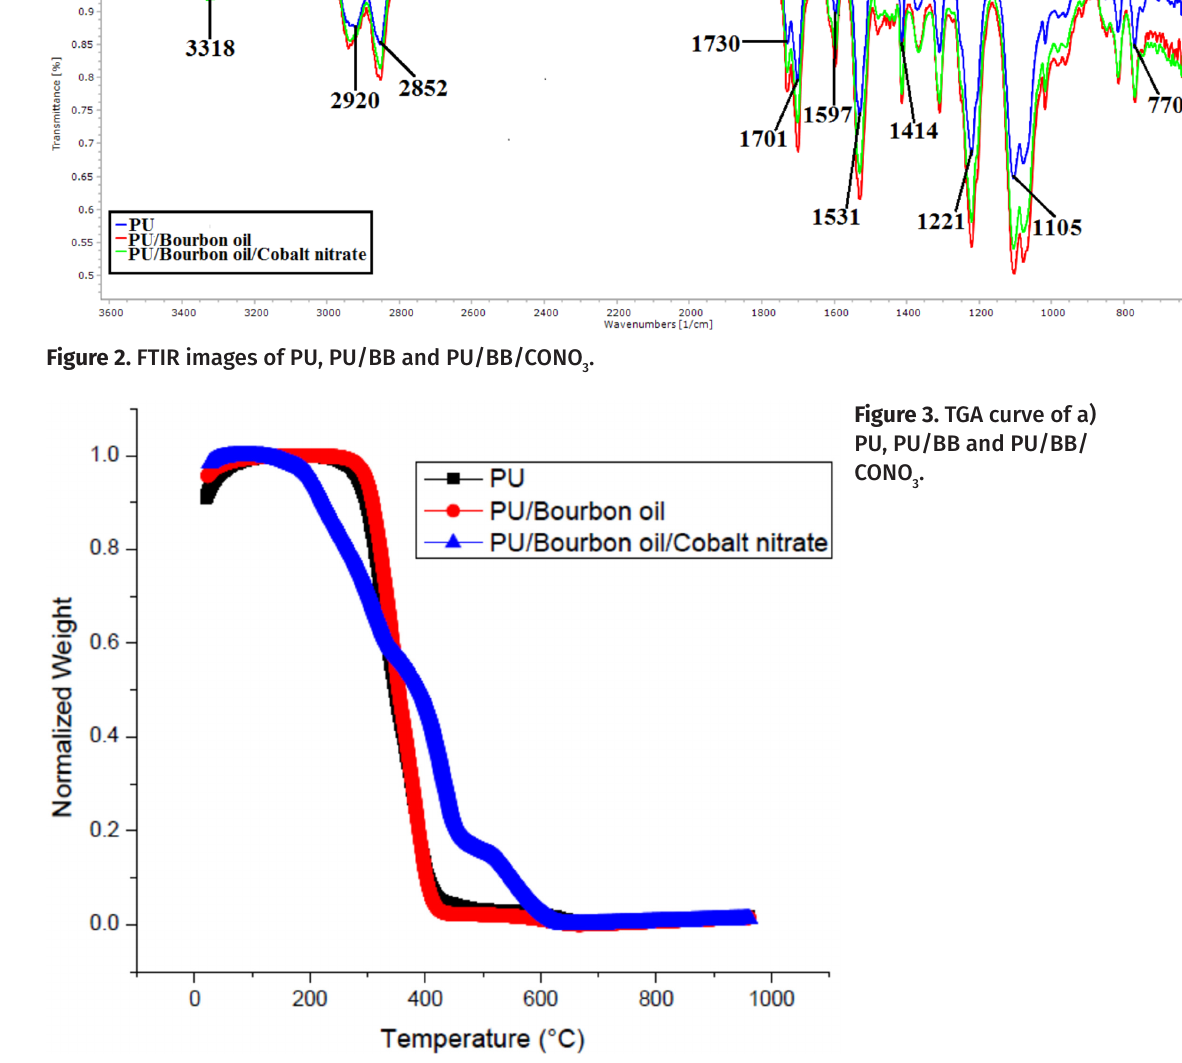
Figure 2. FTIR images of PU, PU/BB and PU/BB/CONO